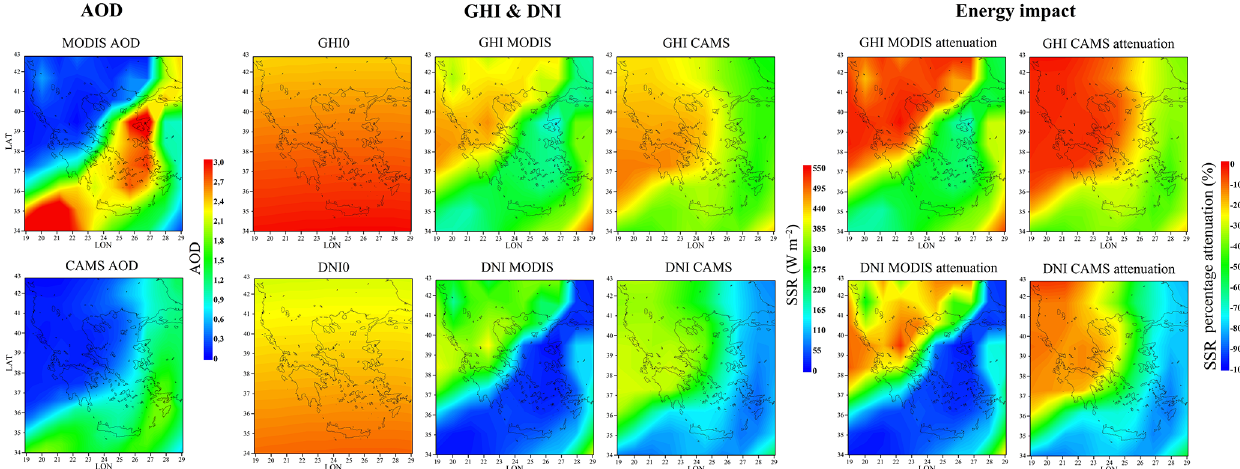
Figure 10. (a) AOD from MODIS level 3 and the CAMS 1-day forecast. (b) RTM simulations at local noon on the day of the incursion on 1 February 2015 for GHI and DNI. GHI0 and DNI0 represent the simulations without dust (with only the effects of SZA). (c) The energy impact in terms of percentage attenuation relative to the dust-free simulations for GHI and DNI under MODIS- and CAMS-based AODs. For the GHI, the attenuation is about 30–70% for MODIS and about 30–60% for the CAMS. For the DNI, the attenuation is about 70–100% for MODIS and about 60–90% for the